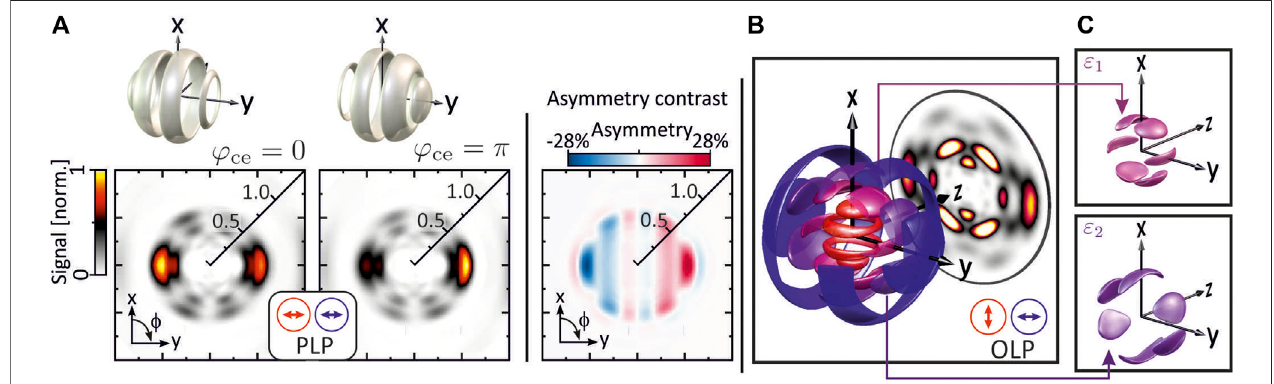
FIGURE 8 | Measured PMDs from bichromatic MPI of sodium and potassium atoms. (A) Retrieved ( x , y )-sections from the photoemission of sodium atoms using CEP-stable (3 ω :4 ω ) PLP fi elds. The left and middle frames show the Abel-inverted sections for φ ce (cid:2) 0 and φ ce (cid:2) π , respectively. The top insets show the corresponding generic 3D PMDs of the wave packets. The calculated asymmetry contrast, depicted in the right frame, shows pronounced asymmetries in the laser polarization plane originatingfromCEP-sensitiveinterbandinterference. (B) Measured andtomographicallyreconstructed 3DPMDfromthree-photonionizationofpotassiumatoms using bichromatic fi elds with incommensurable frequencies. The PMD shows four energetically separated shells originating from single-color and frequency mixing contributions, equidistantly centered around energies ε i ( i (cid:2) 0, 1, 2, 3). (C) The partial wave packets from the intermediate energy channels ε 1 and ε 2 , exhibit pseudo c 6 rotational symmetry resulting from intraband